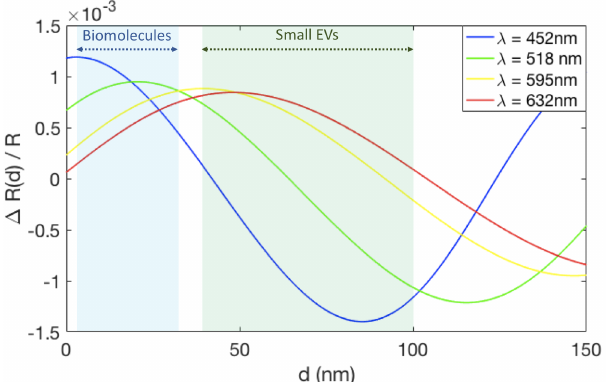
Figure 5. The change in reflectance signal due to biomass accumulation on an IRIS substrate with 110 nm of oxide for four different wavelengths, corresponding to the LEDs available on the IRIS system. The light blue region indicates the expected thickess range for biomolecules accumulation (1–30 nm), while the light green region shows the range expected for EVs (40–100